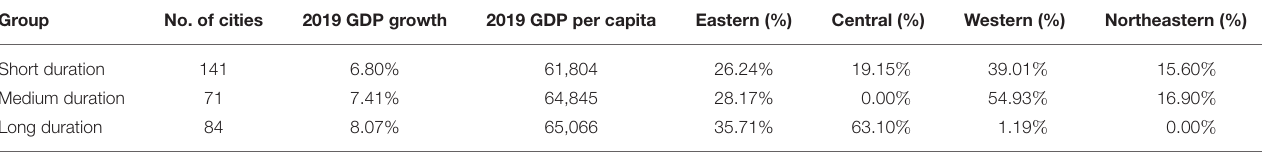
TABLE 2 | The number of cities, average GDP growth in 2019, average GDP per capita in 2019, and located regions in three groups by duration of Level I ERS. Group No. of cities